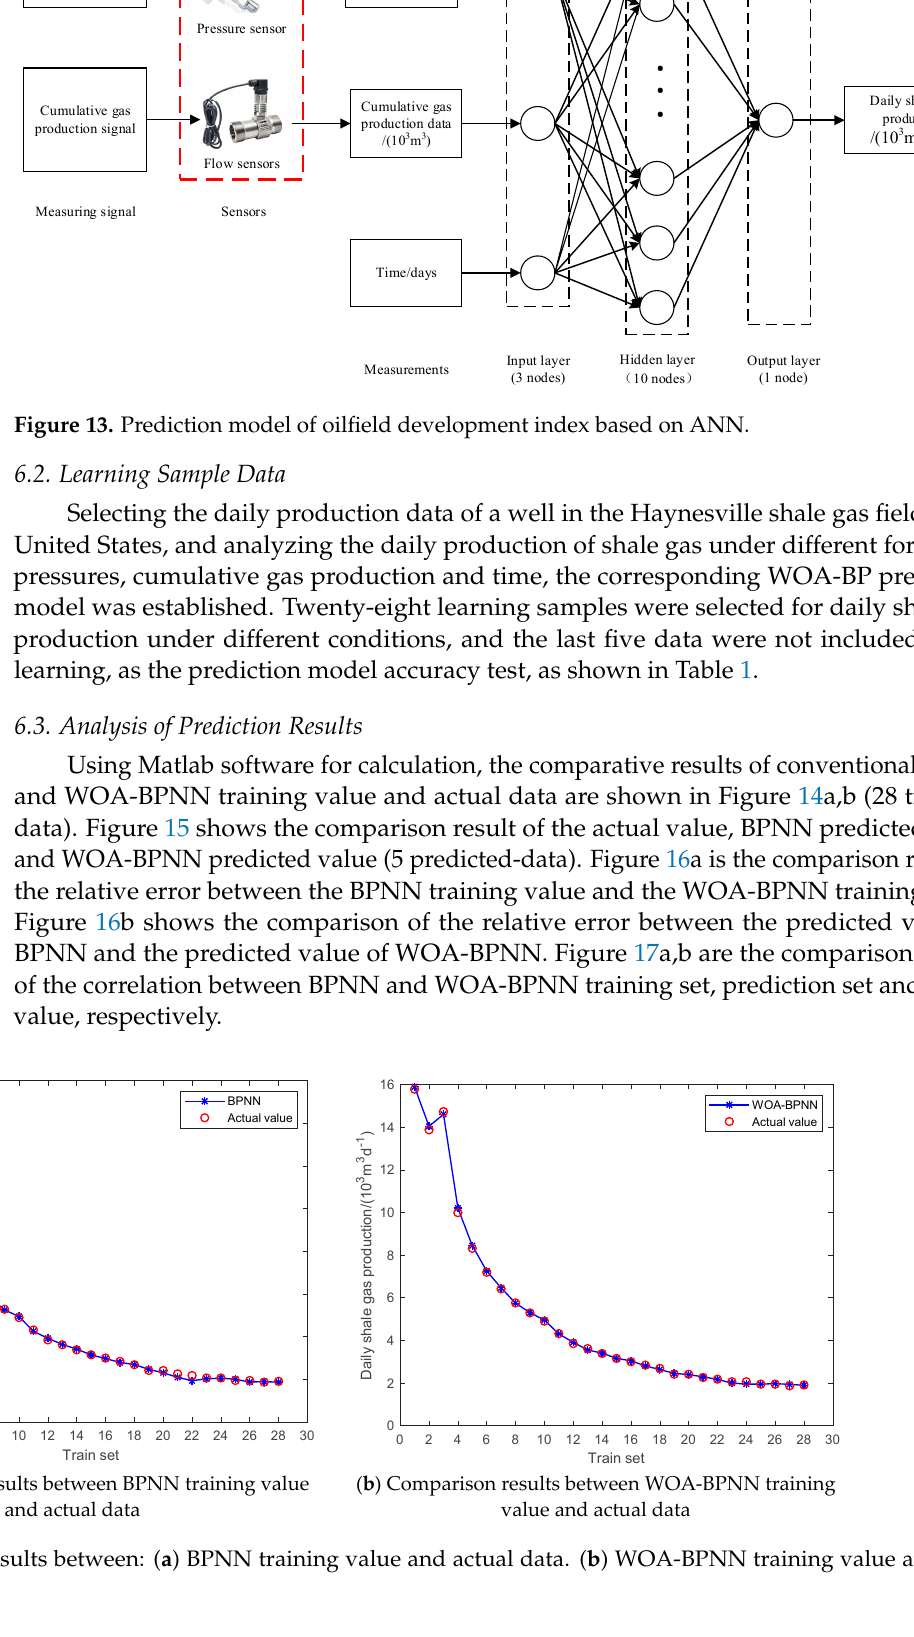
Figure 14. Comparison results between: ( a ) BPNN training value and actual data. ( b ) WOA-BPNN training value and actual data.